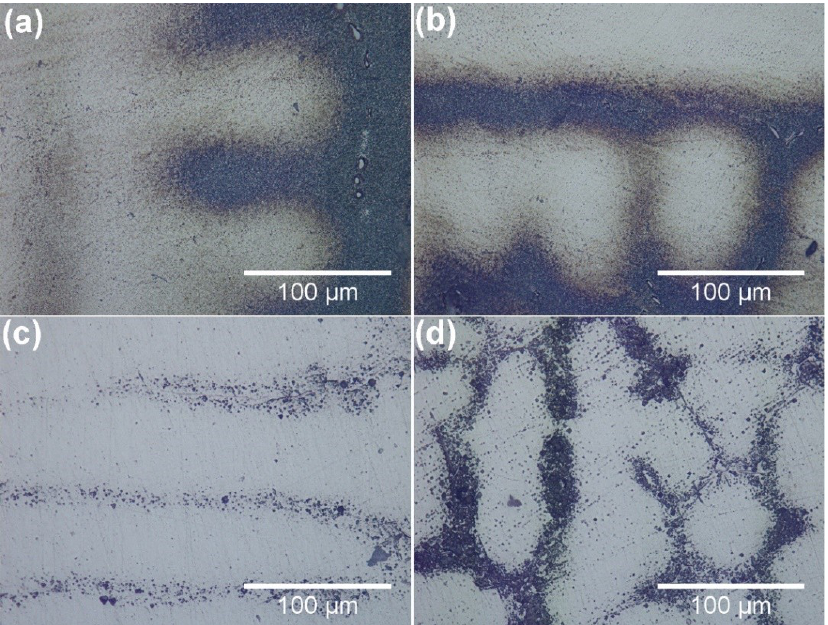
Figure 1. Optical microscope (OM) images of the as-cast GTD222 superalloy with different cooling rates during the solification process, ( a ) cooling at 2.5 K/min, ( b ) cooling at 5 K/min, ( c ) cooling at 10 K/min, ( d ) cooling at 20 K/min.